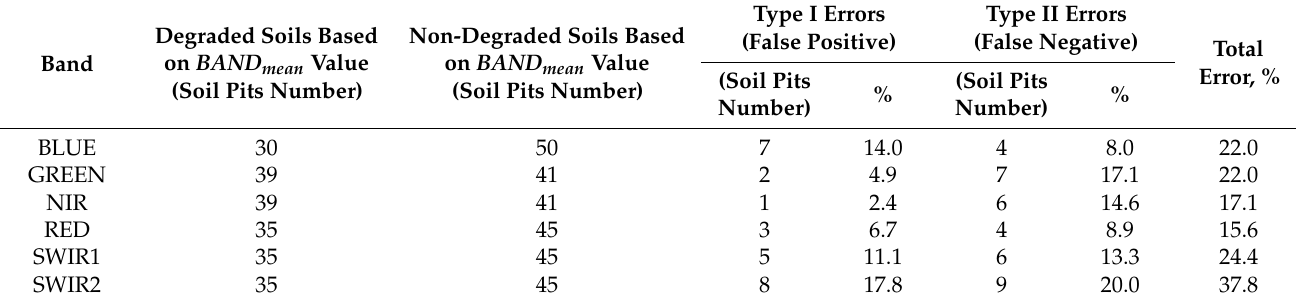
Table 5. Type I and II errors for soil degradation